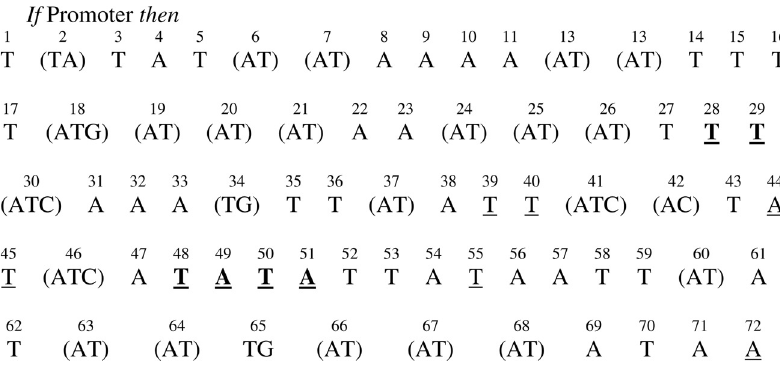
Figure 6 - Rule prototype for promoter sequence obtained from NN